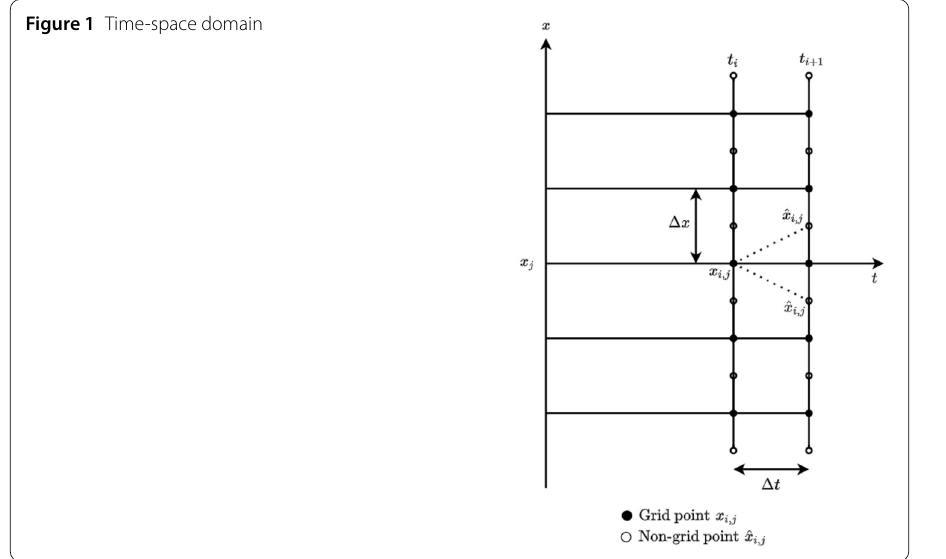
Figure 1 Time-space